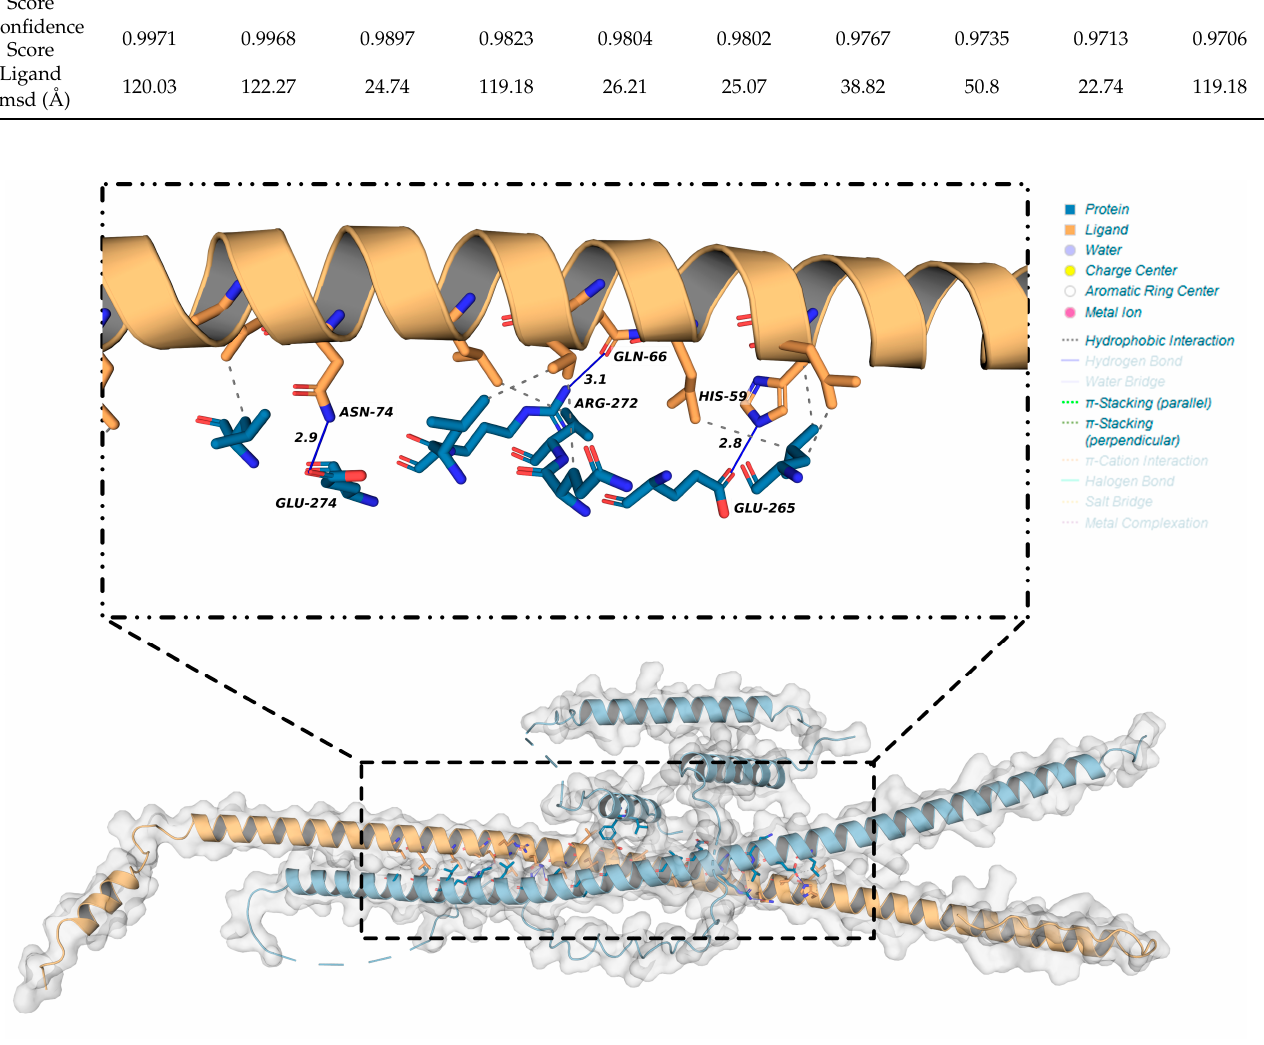
Table 3. The top 10 docking models between OsbZIP14 and OsbZIP58.